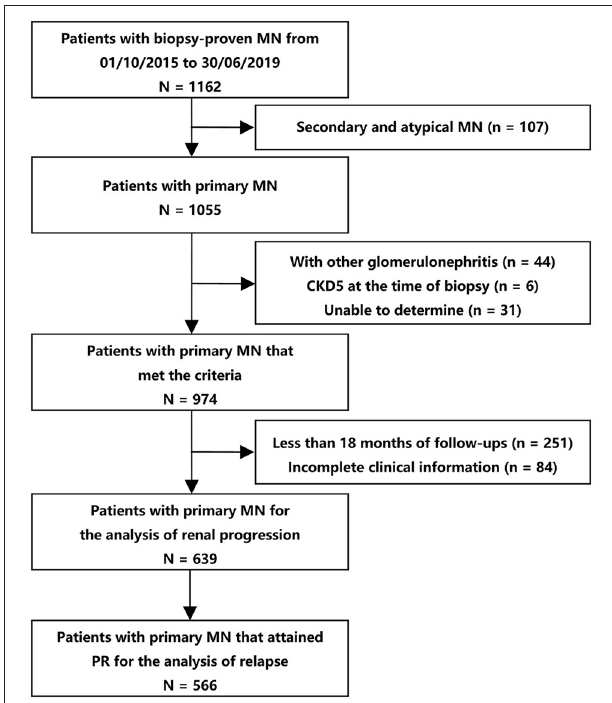
FIGURE 1 | Flow diagram of patient selection. The patients that reached PR ( N = 566) were used for the analyses of the association between initial hematuria and relapse. All the eligible patients ( N = 639) were included for the analyses of the association between microhematuria and kidney disease progression. CKD, chronic kidney disease; MN, membranous nephropathy; PR, partial